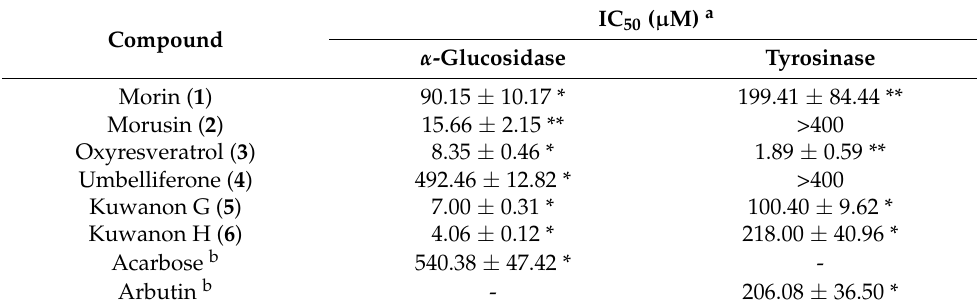
Table 7. α -Glucosidase and tyrosinase inhibitory activities of isolated compounds.